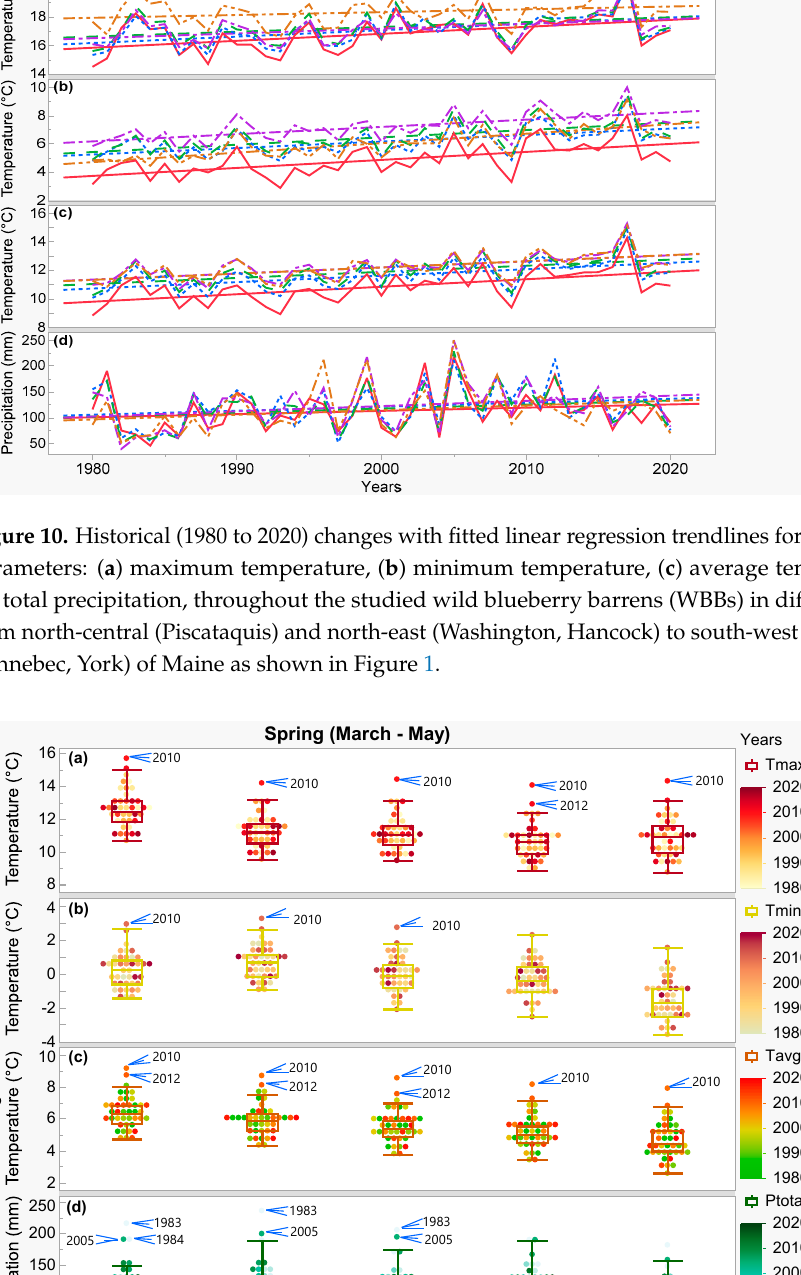
Figure 9. Comparison of historical (1980 to 2020) fall climate parameters: ( a ) maximum temperature, ( b ) minimum temperature, ( c ) average temperature, and ( d ) total precipitation among the studied wild blueberry barrens (WBBs) in different counties from north-central (Piscataquis) and north-east (Washington, Hancock) to south-west (Knox, Lincoln, Kennebec, York) of Maine as shown in Figure 1.